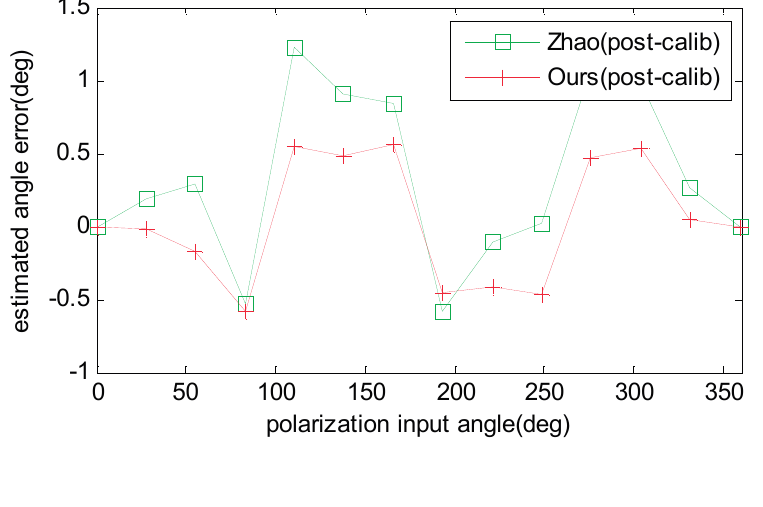
Figure 12. Estimated angle error comparison of the post-calibration with outdoor test